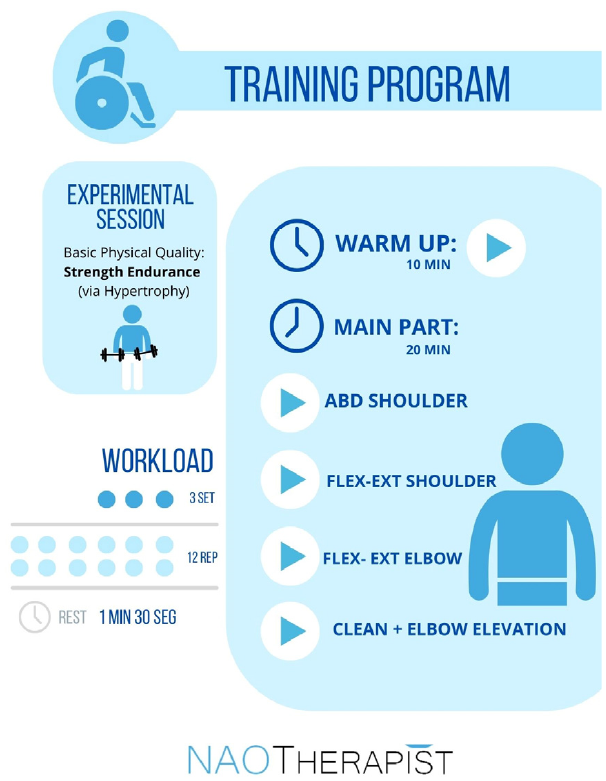
Figure 3. Exercises performed during an experimental session with the humanoid robot Robic.